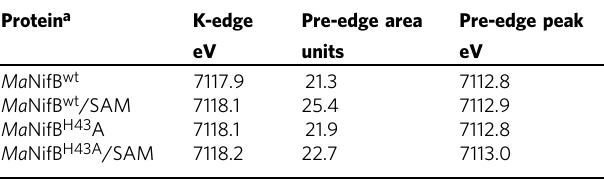
a Data are fi t between 7108 and 7117eV from the experimental data. Data for Ma NifB wt and Ma NifB wt /SAM are taken from Ref. 16